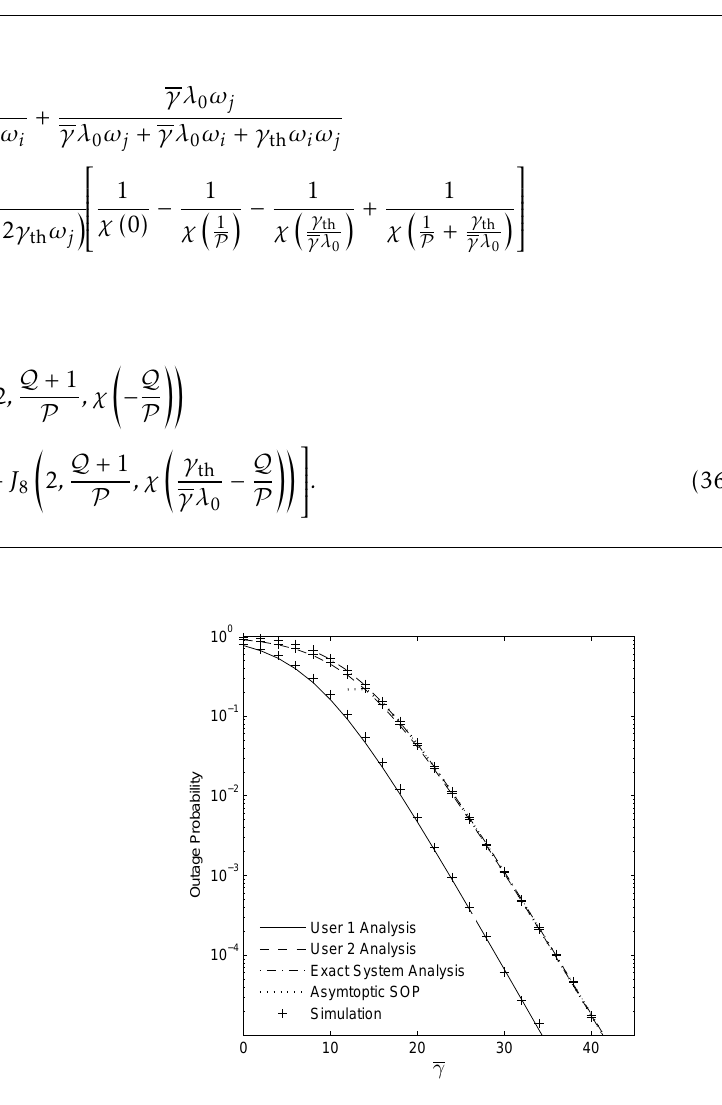
Figure 2. Outage Probability of MRC vs γ with R = 1 and η = 3 .